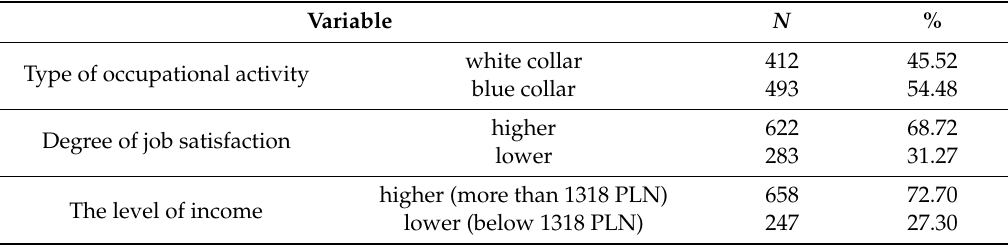
Table 3. Self-declared characteristics of the occupational environment of the respondents ( N =